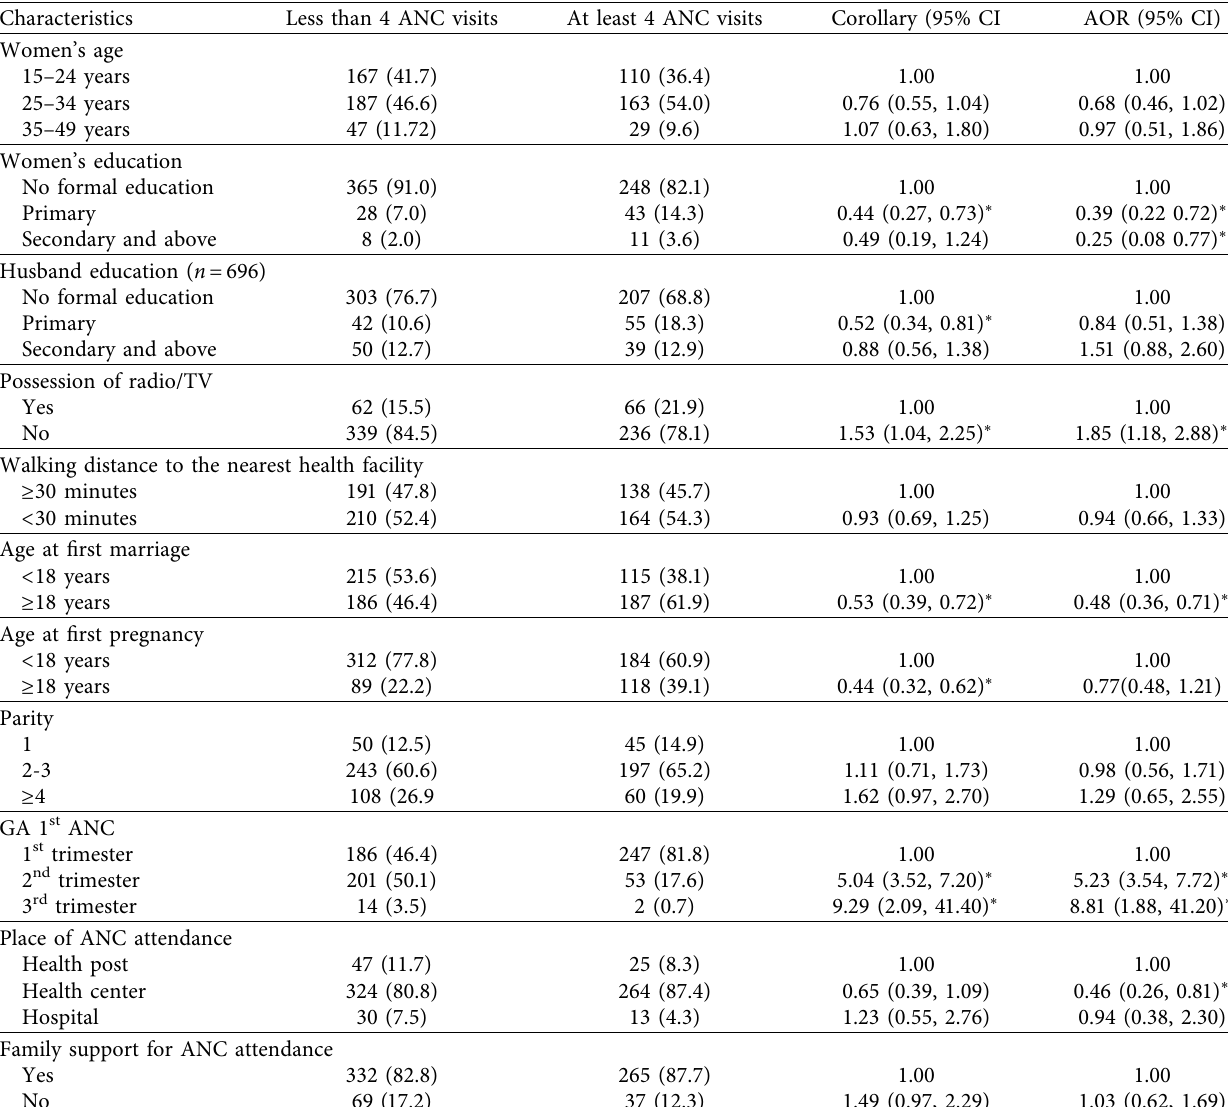
Table 3: Factors associated with nonadherence to the recommended antenatal care visits among women in the pastoral community, Northeast Ethiopia, 2020 ( n �